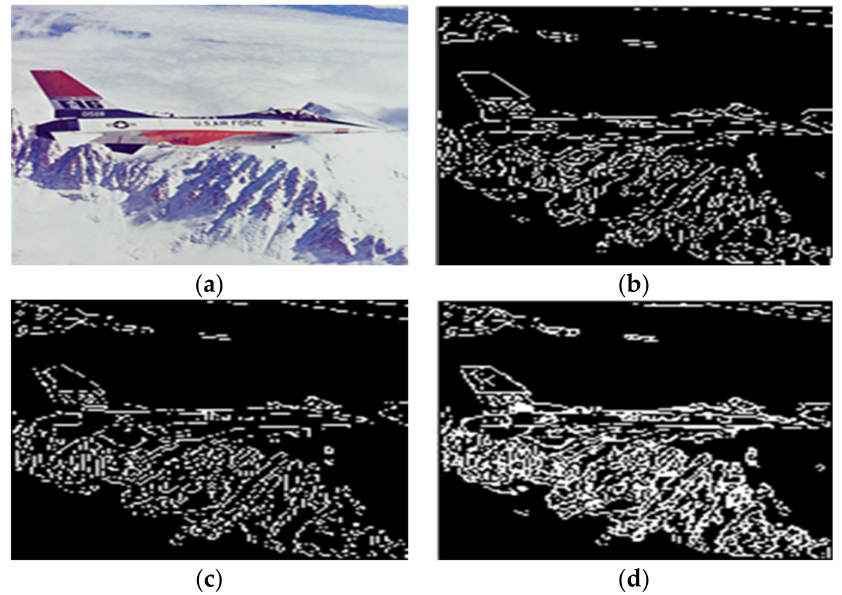
Figure 11. Segmentation results of Airplane by different algorithms. ( a ) The original image. ( b ) The water division lines were obtained by the algorithm in this paper. ( c ) The water division lines were obtained by the algorithm in [11]. ( d ) The water division lines were obtained by the algorithm in [15].